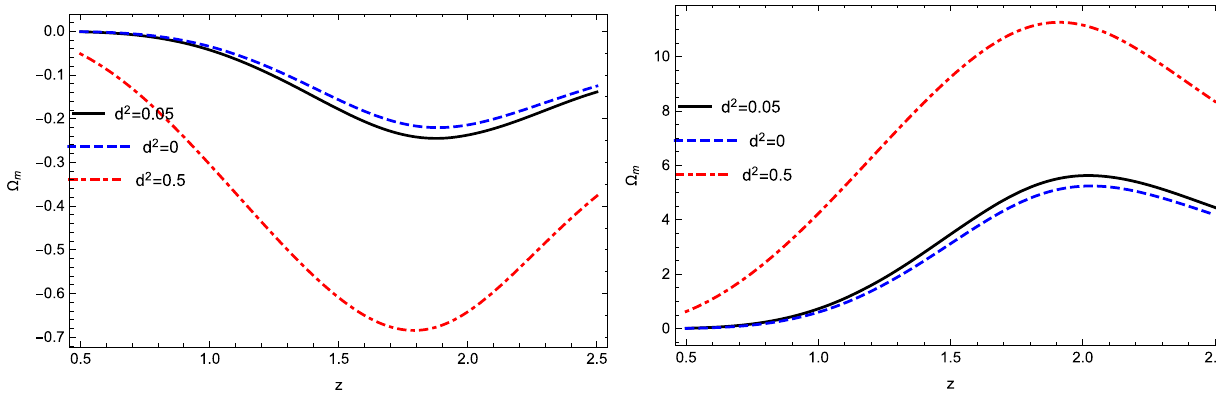
Fig. 30 Plot of (cid:9) m verses z for u = 1 and u = 2 . 002 for Bianchi type-VI model